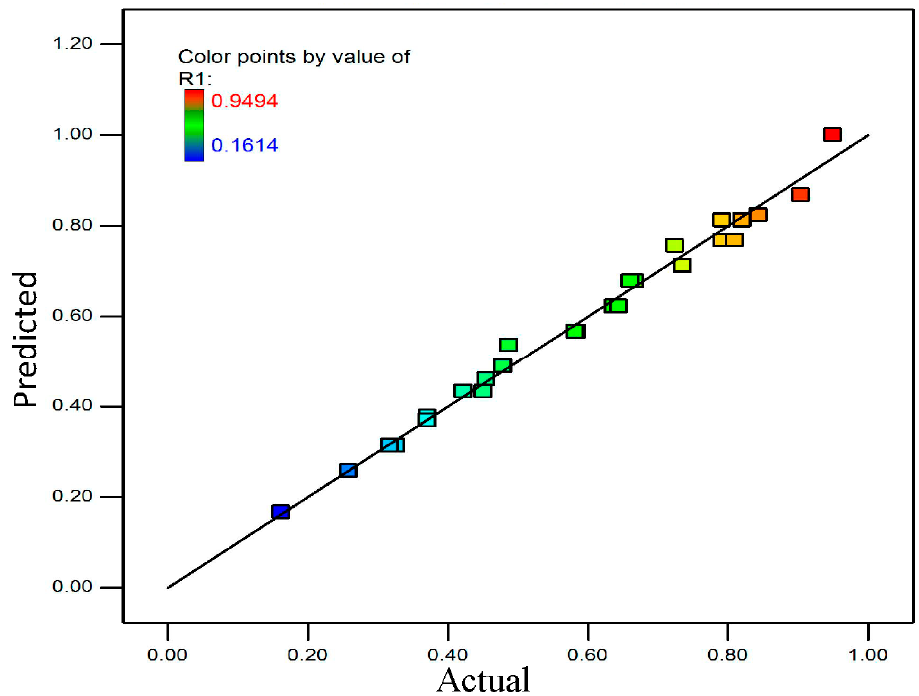
Figure 2. Plot of predicted vs. actual data of the modified model in MH.